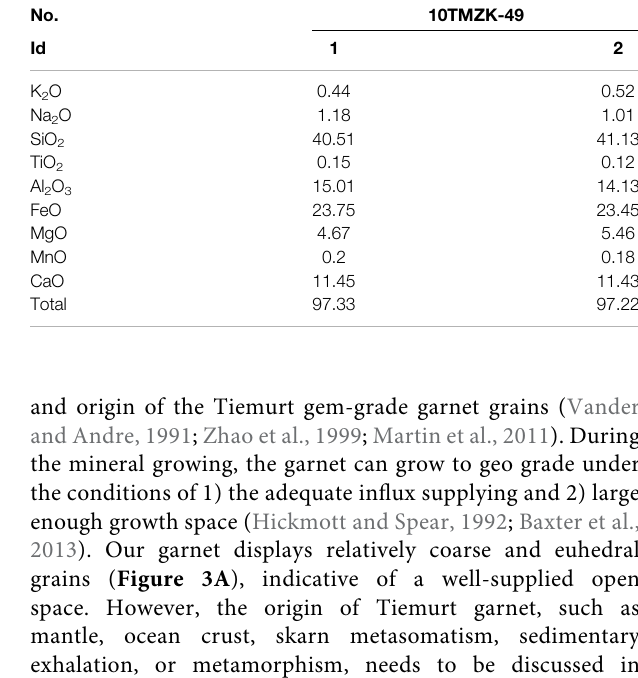
TABLE 3 | EMPA geochemical data (wt%) of the Tiemurt amphibole.